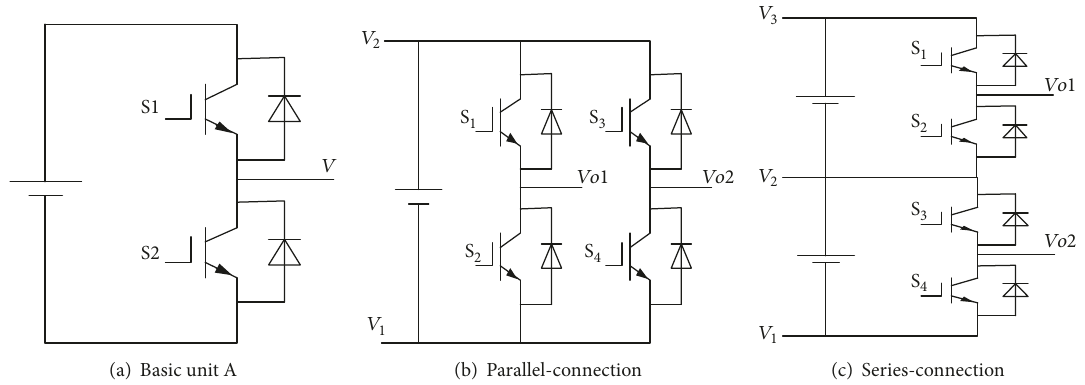
Figure 3: Parallel-series-connection topology of the same basic